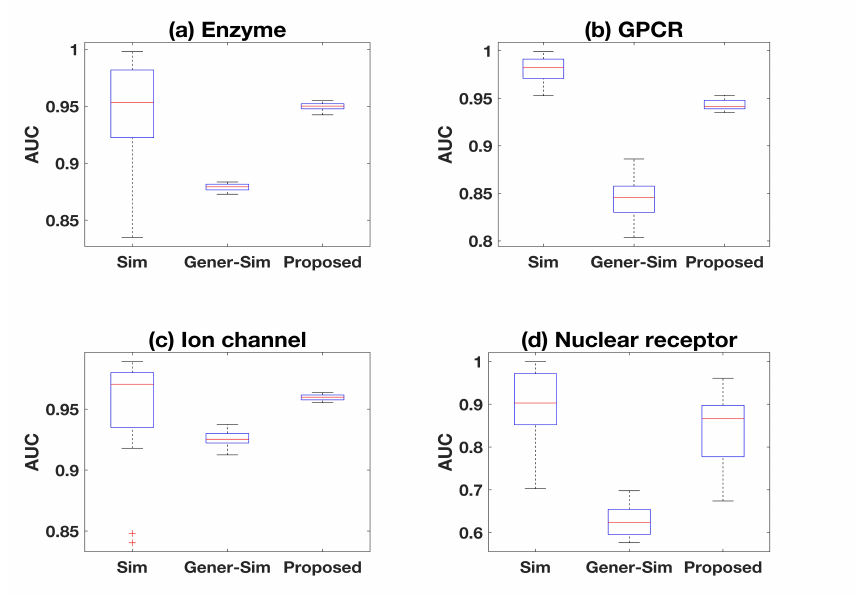
Figure A2. Comparison between simple connection of feature pairs and